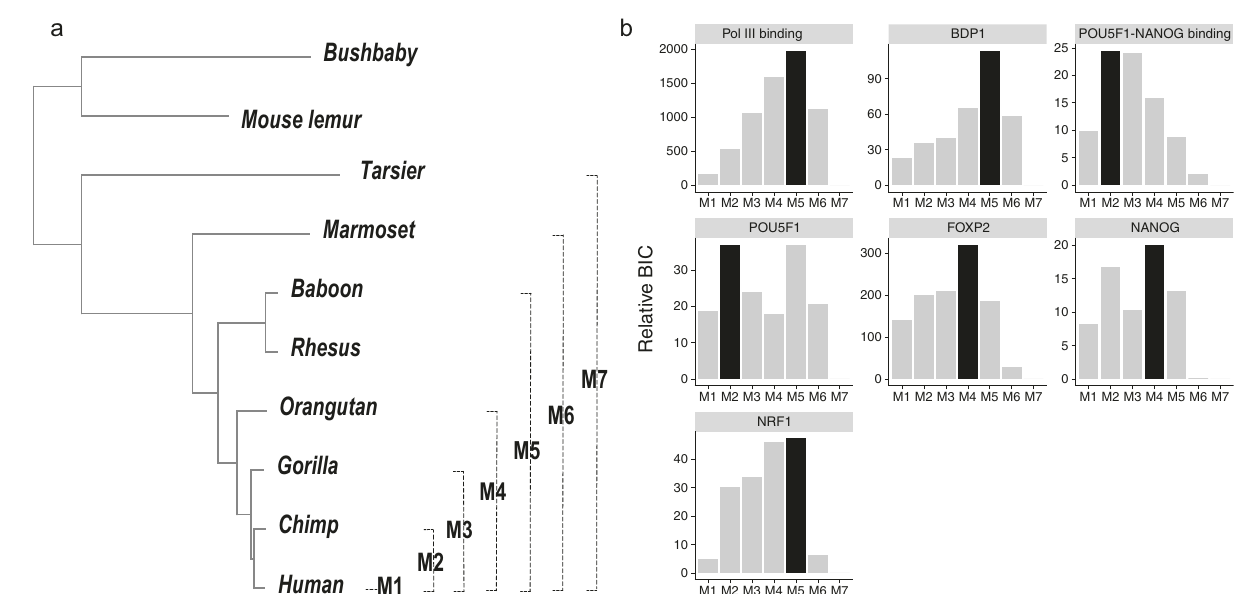
Fig. 7 | Lineagesassociatedwith accelerated evolutioninTFBS groups.a The sevenforeground lineages examined in the model comparison analysis. b Model fi t with different foreground lineages. The black bars indicate the best- fi t foreground